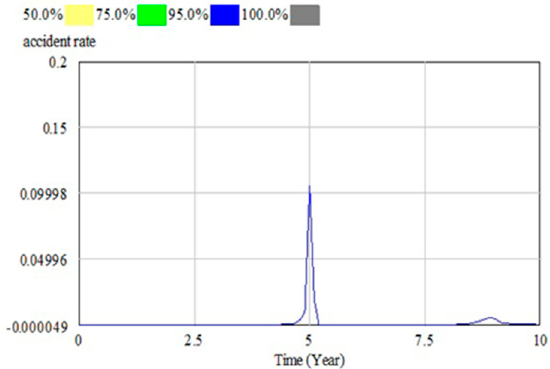
Figure 23. SD sensitivity trace range of ‘reliability’ variable.